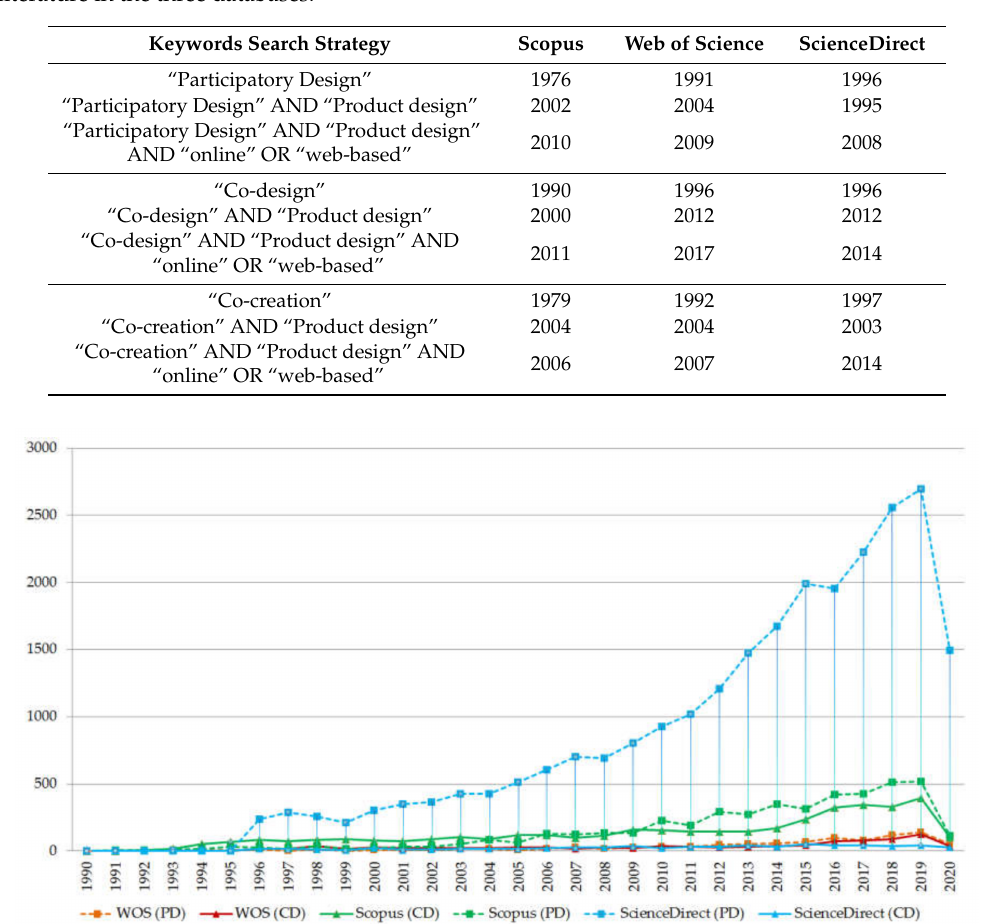
Figure 3. The timeline and amount of literature related to participatory design (PD) and co-design (CD) in the three